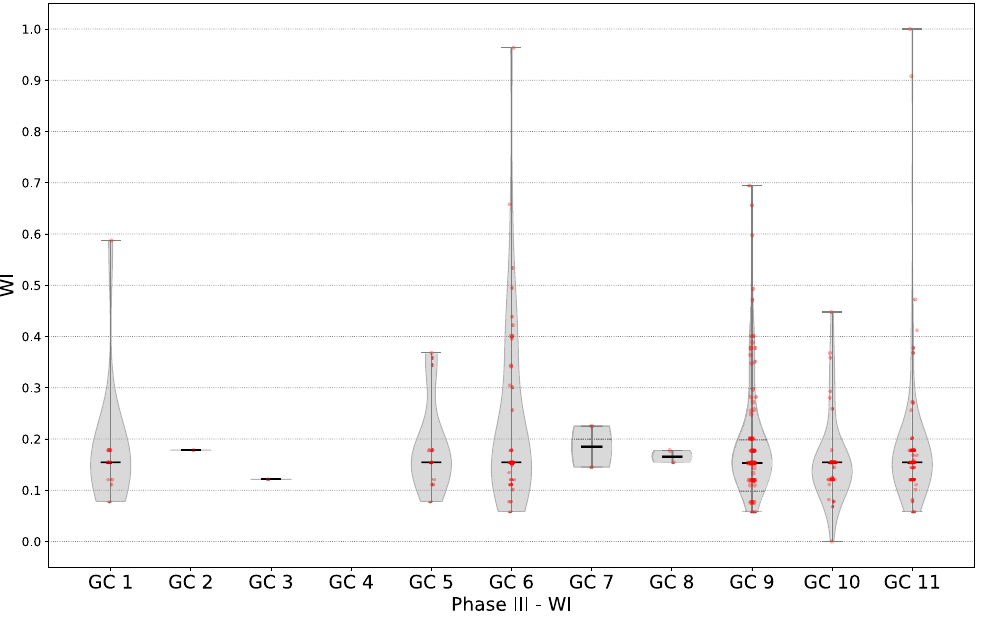
Figure 9: WI distribution of Dunaújváros Phase III ( c. 1650 – 1450 BCE ) by GC. Bold black bars indicate the